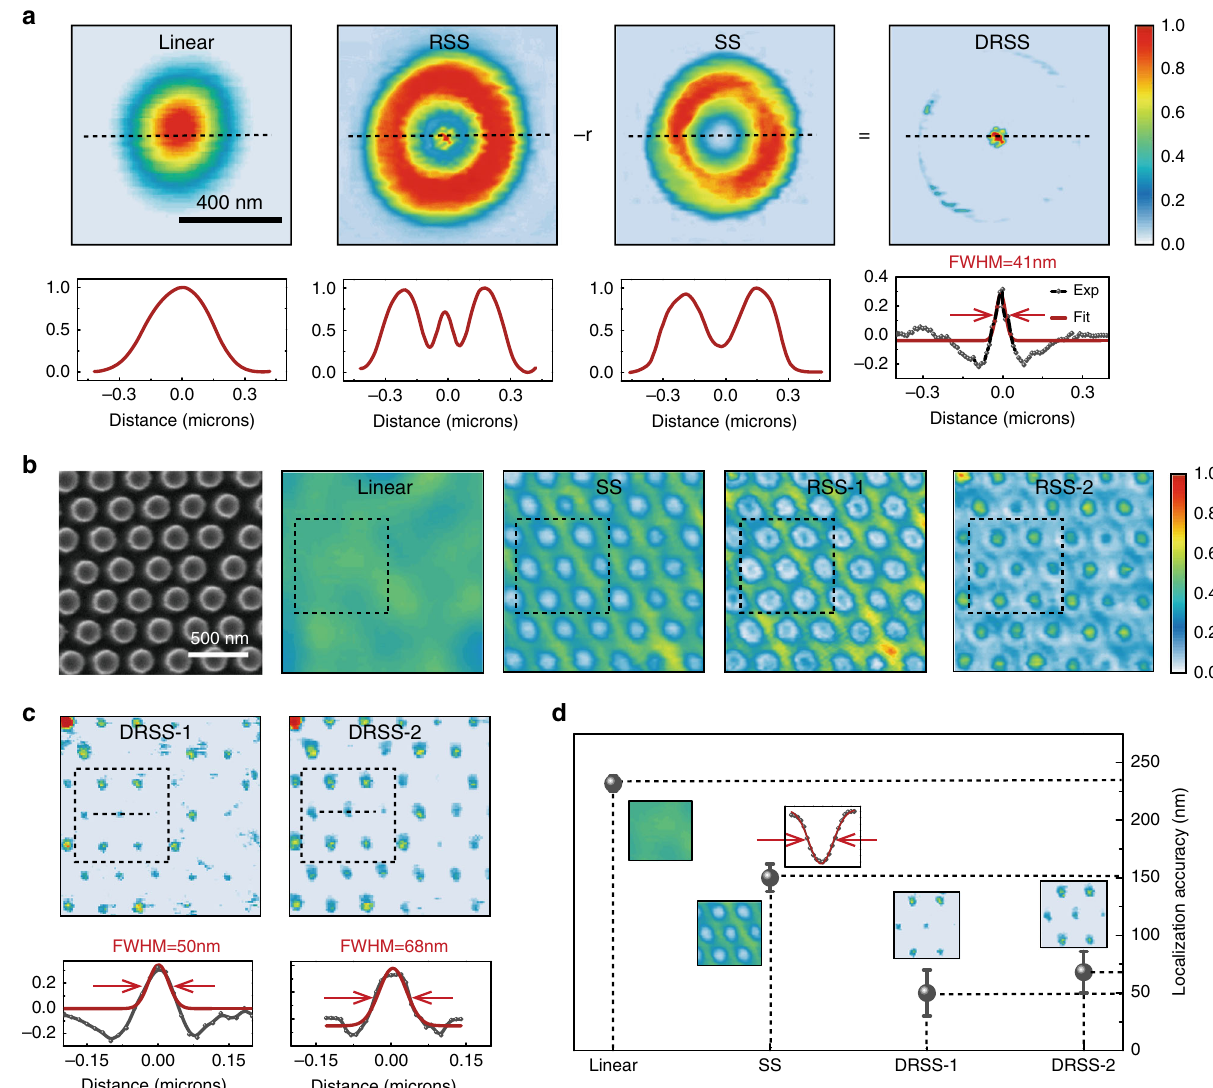
Fig. 4 Optically localizing Si nanodisks packed in dense arrays based on the photothermal nonlinear scattering. a PSF of a single isolated Si nanodisk at different irradiance intensities. Differential image (denoted as DRSS) between RSS and SS yields a localization precision with fi tted FWHM of 41 nm with r to be a subtractive factor. b PSFs of nonlinear scattering from periodic Si nanodisk arrays evolve with increasing excitation intensities. Correlated SEM image is also presented. The dense array of Si nanodisks in conventional confocal image is undistinguishable at the low excitation intensity. SS image generates a negative contrast whilst in RSS a central spike emerges. The onset of RSS process is presented in image RSS-1. When the degree of RSS increases, the central spike becomes more obvious (RSS-2). c Far- fi eld optical localization of Si nanodisk arrays by means of differential image between RSS-1/RSS-2 and SS. d Localization accuracy scaling as PSFs obtained at different stages of nonlinear scattering. The error bars represent the deviations of FWHM values from 39 nanodisks in the scanning